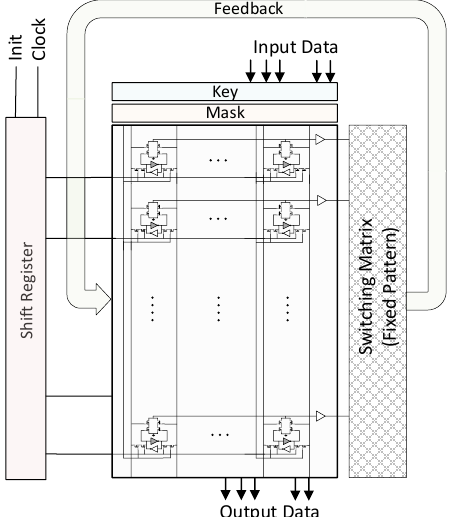
Figure 5. The ultra-area-efficient FFT processor based on singleton’s FFT and feedback.